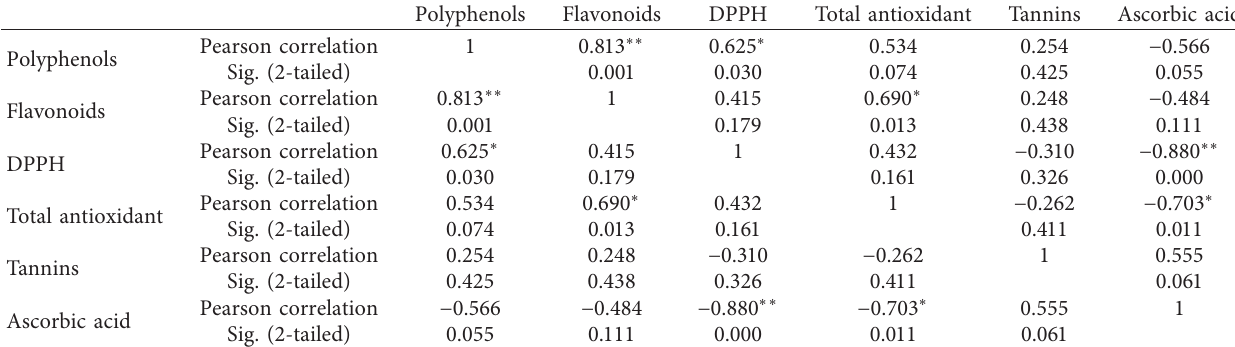
Table 1: Correlation between the analyzed biochemical and antioxidant activity. DPPH: 1,1-diphenyl-2-picrylhydrazyl.